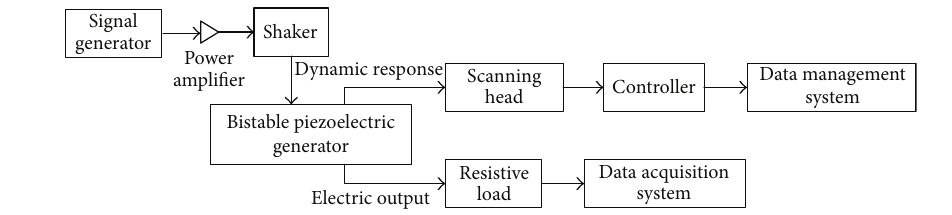
Figure 15: Schematic of the experimental process.